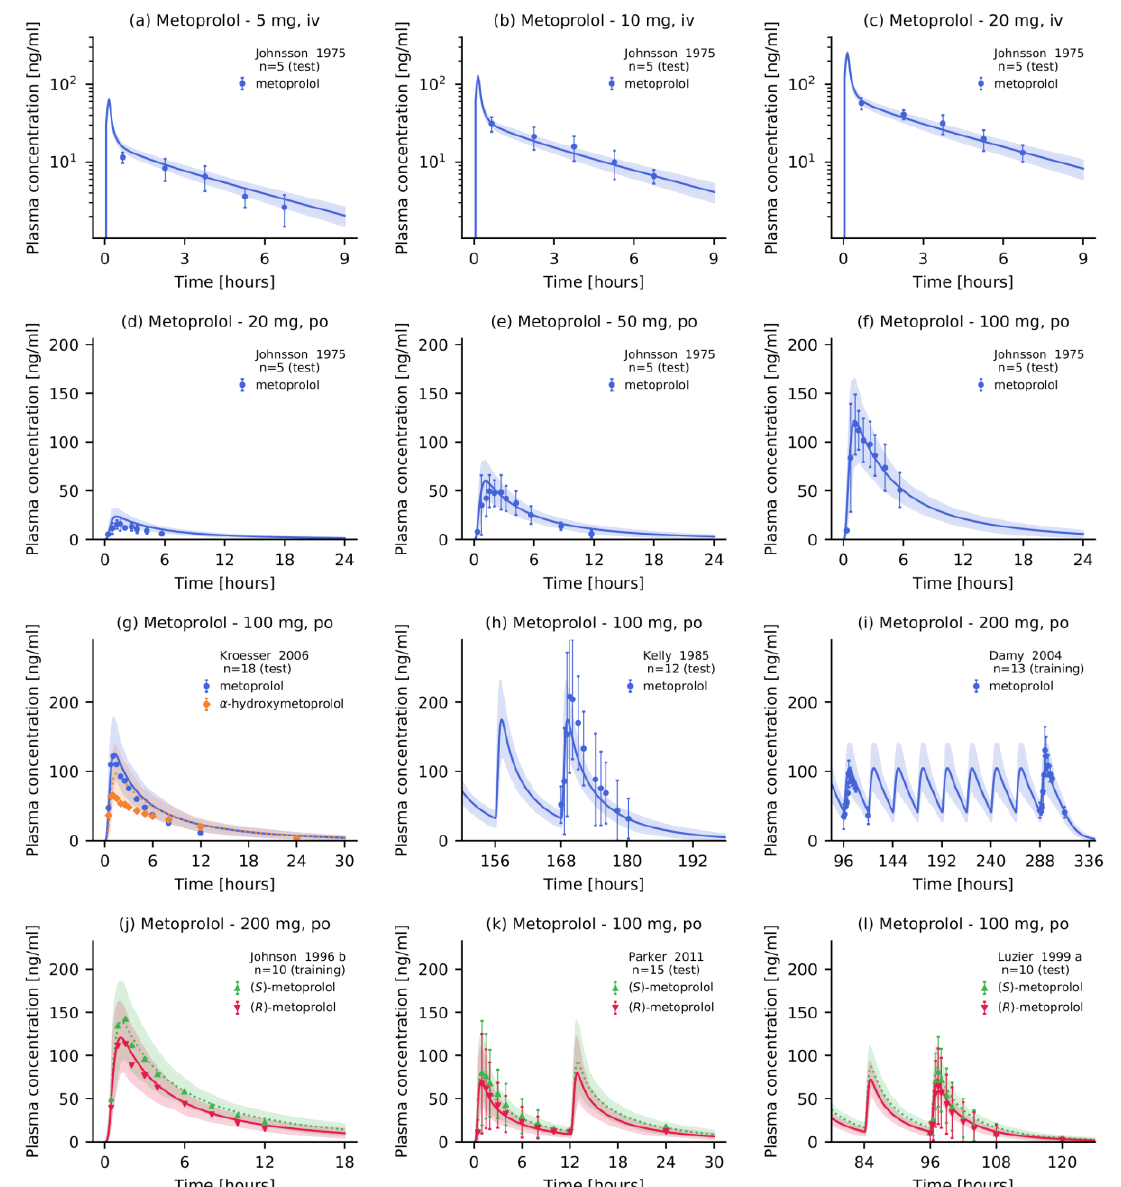
Figure 2. Metoprolol plasma concentrations. Model predictions of metoprolol and its metabolite Figure 2 α -hydroxymetoprolol plasma concentration-time profiles of selected ( a – c ) intravenous and ( d – l ) oral studies of the training and test datasets, compared to observed data [43–45,47–50]. Population predictions (n = 100) are shown as lines with ribbons (arithmetic mean ± standard deviation (SD)), symbols represent the corresponding observed data ± SD. Detailed information on all clinical studies is listed in Supplementary Table S2.2.1. iv: intravenous, po: oral. Goodness-of-fit plots showing plasma concentrations, AUC last and C max values,